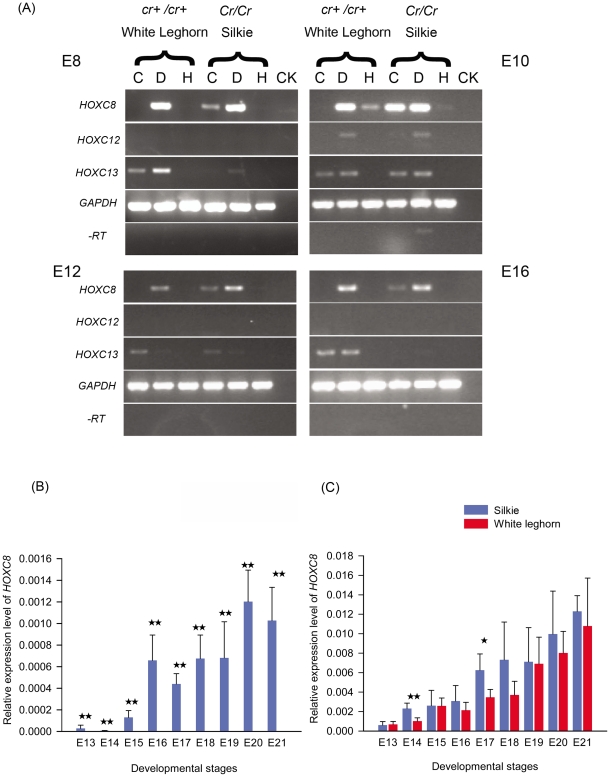
Expression analysis of HOXC genes in Silkie (crested) and White Leghorn (non-crested) chickens.(A) HOXC8, HOXC12 and HOXC13 genes were detected by RT-PCR in three tissues (cranial skin, dorsal skin and heart) of Silky and White Leghorn chickens at four developmental stages (E8, E10, E12, E16). C: Cranial skin; D: Dorsal skin; H: Heart. GAPDH was used as a positive and normalised control. -RT indicates a reaction without reverse transcriptase. CK indicates a reaction with water as the template. (B)&(C) q-PCR results for HOXC8 expression level in cranial skin (B); and in dorsal skin (C) during chicken developmental stages E13 to E21 comparing Crested and non-crested chickens. No HOXC8 expression was detected in cranial skin from non-crested birds. (*, P<0.05; **, P<0.01).